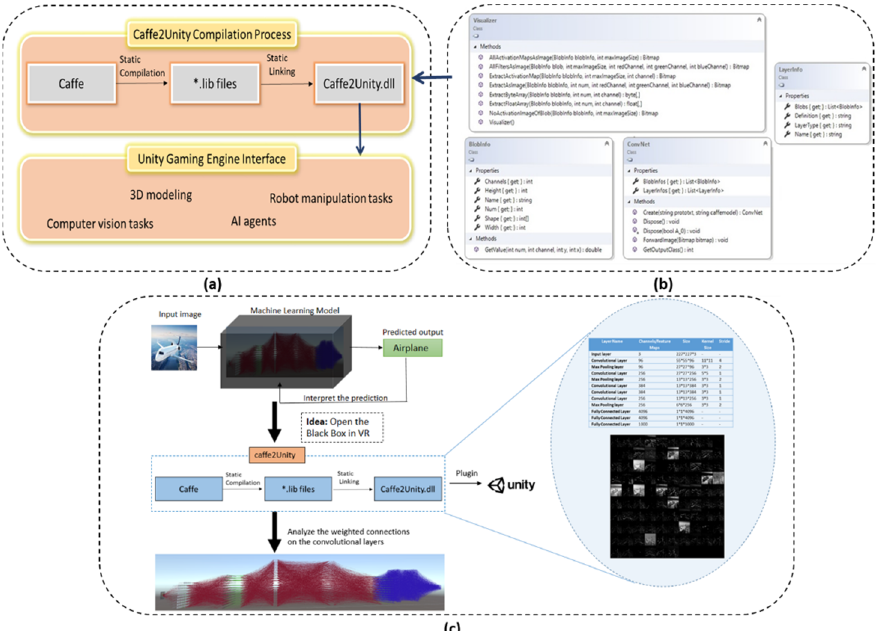
Figure 1. ( a ) Flow chart of the compilation process of the Caffe2Unity.dll and its interfacing with Unity to perform various tasks. In its current form, we used the DLL for image classification as an application domain. ( b ) Prototypes and attributes of the main classes used in the Caffe2Unity.dll to achieve our goal. ( c ) Snapshot of the visualization strategy illustrating the immersive model of AlexNet with details of all layers and activation maps that are used in the VR environment.